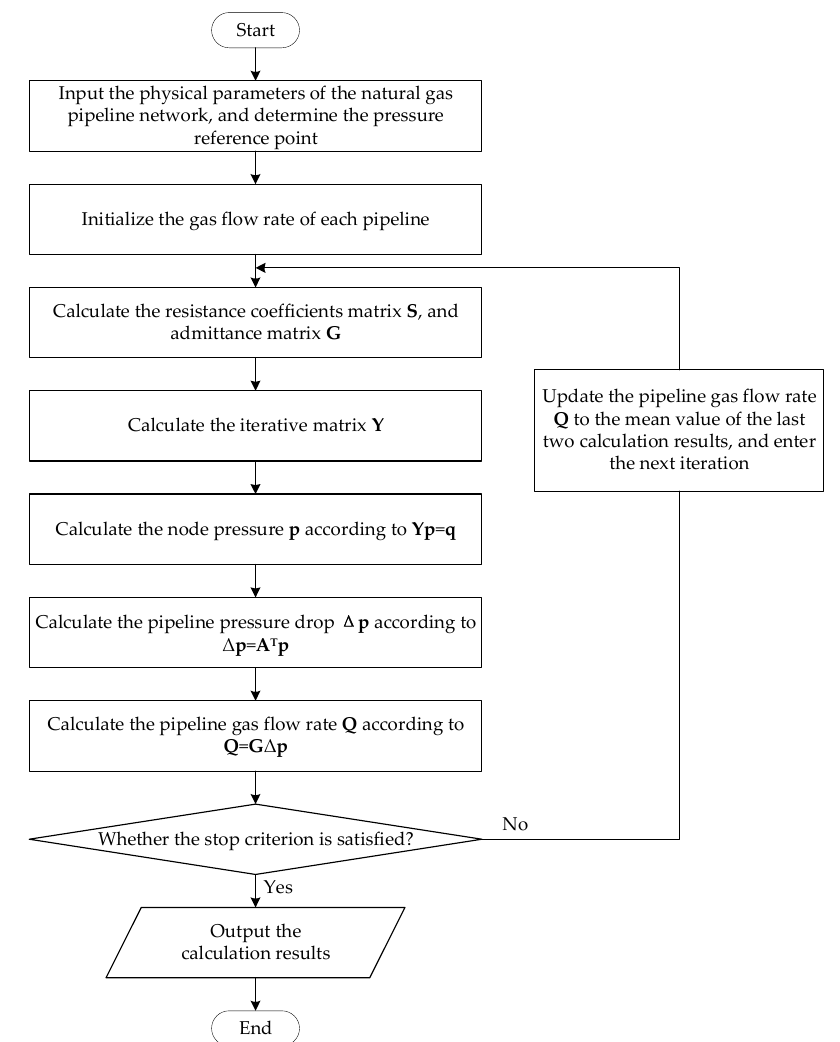
Figure 2. Algorithm flowchart of natural gas steady flow calculation.